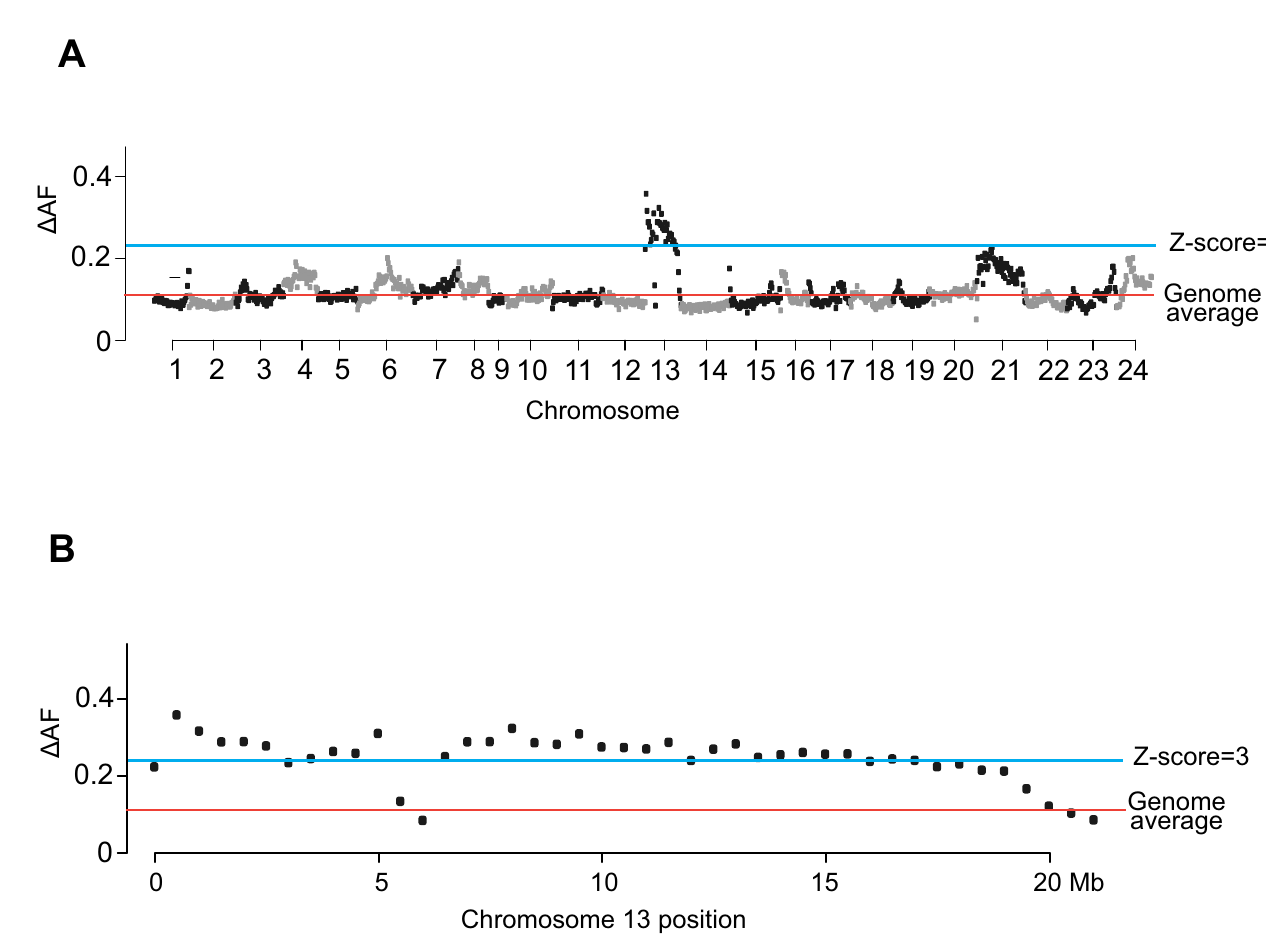
Fig 1. Genetic differentiation between phenotypic males and females highlights chr13 as the putative Y-chromosome. A Average male vs. female Δ AF for 500 kb windows along each assembled chromosome. The genome-average Δ AF is indicated as a horizontal line together with a line indicating Z-score = 3, i.e. the Δ AF-value corresponding to 3 SD above the genome average). B Average Δ AF for 500 kb windows along chr13 with genome average Δ AF and 3 SD above genome average Δ AF indicated by horizontal